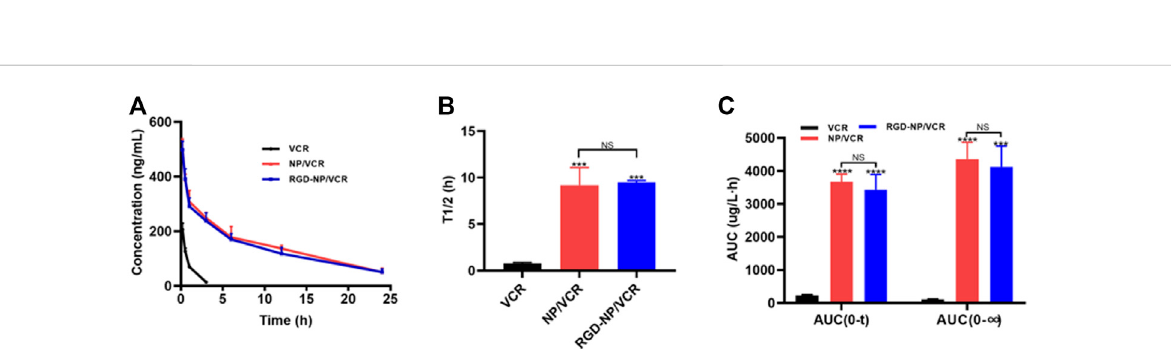
FIGURE 3 (A) Concentration-Timecurveand (B,C) pharmacokineticsparameter